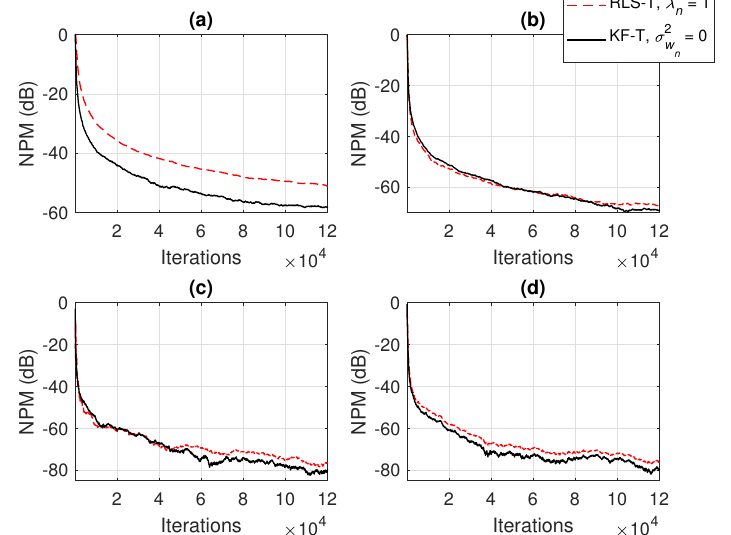
Figure 5. Normalized projection misalignment (NPM) of the RLS-T algorithm using λ n = 1, n = = 0, n = 1,2, . . . , N , for the identification of the individ- 1,2, . . . , N and the KF-T using σ 2 w n (cid:104) (cid:105) (cid:104) (cid:105) h 1 ( t ) , (cid:98) h 1 ( t ) h 2 ( t ) , (cid:98) h 2 ( t ) ual impulse responses, h n ( t ) , n = 1,2, . . . , N . ( a ) NPM , ( b ) NPM , (cid:104) (cid:105) (cid:104) (cid:105) h 3 ( t ) , (cid:98) h 3 ( t ) h 4 ( t ) , (cid:98) h 4 ( t ) ( c ) NPM , and ( d ) NPM